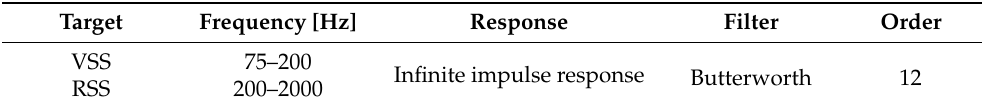
Table 1. Specification of frequency filters for vascular sound signal (VSS) and respiratory sound signal